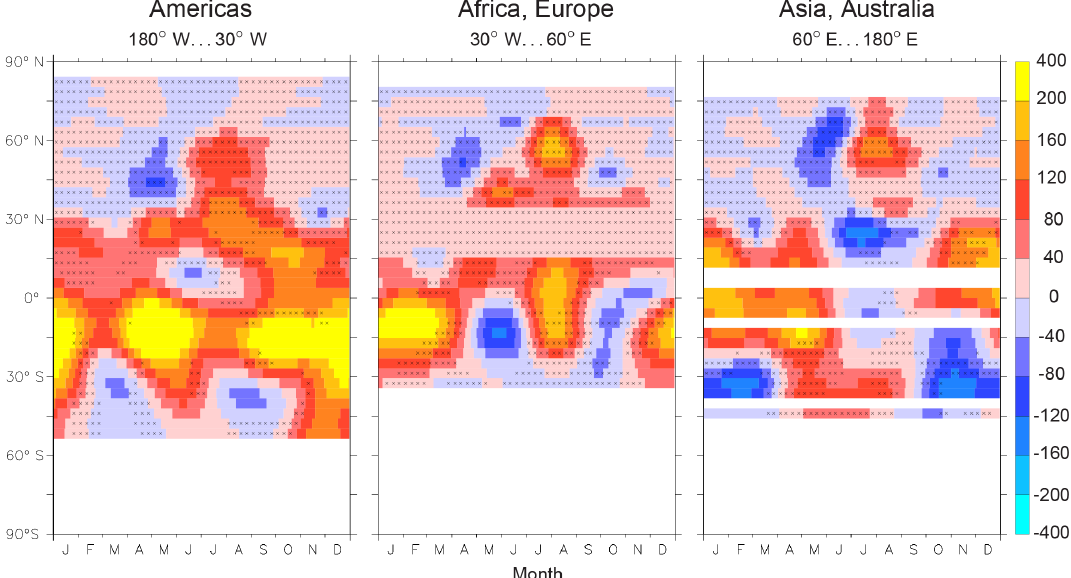
Figure 1. Inter-annual climate sensitivity γ NEE- T in (gCm − 2 yr − 1 )K − 1 shown as Hovmöller diagrams: longitudinal averages of γ NEE- T are plotted as colour over latitude (vertical) and month of the year (horizontal). The stippling indicates robustness: crosses mark values with absolute deviations ≤ 40(gCm − 2 yr − 1 )K − 1 (one colour level) of all sensitivity cases from the base